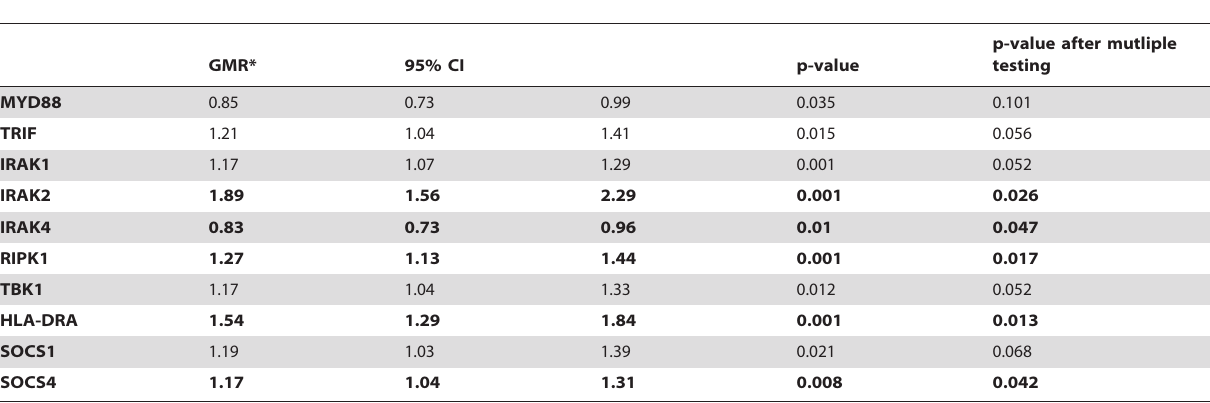
Table 2. Association of farm life with gene expression of TLR signaling cascade.